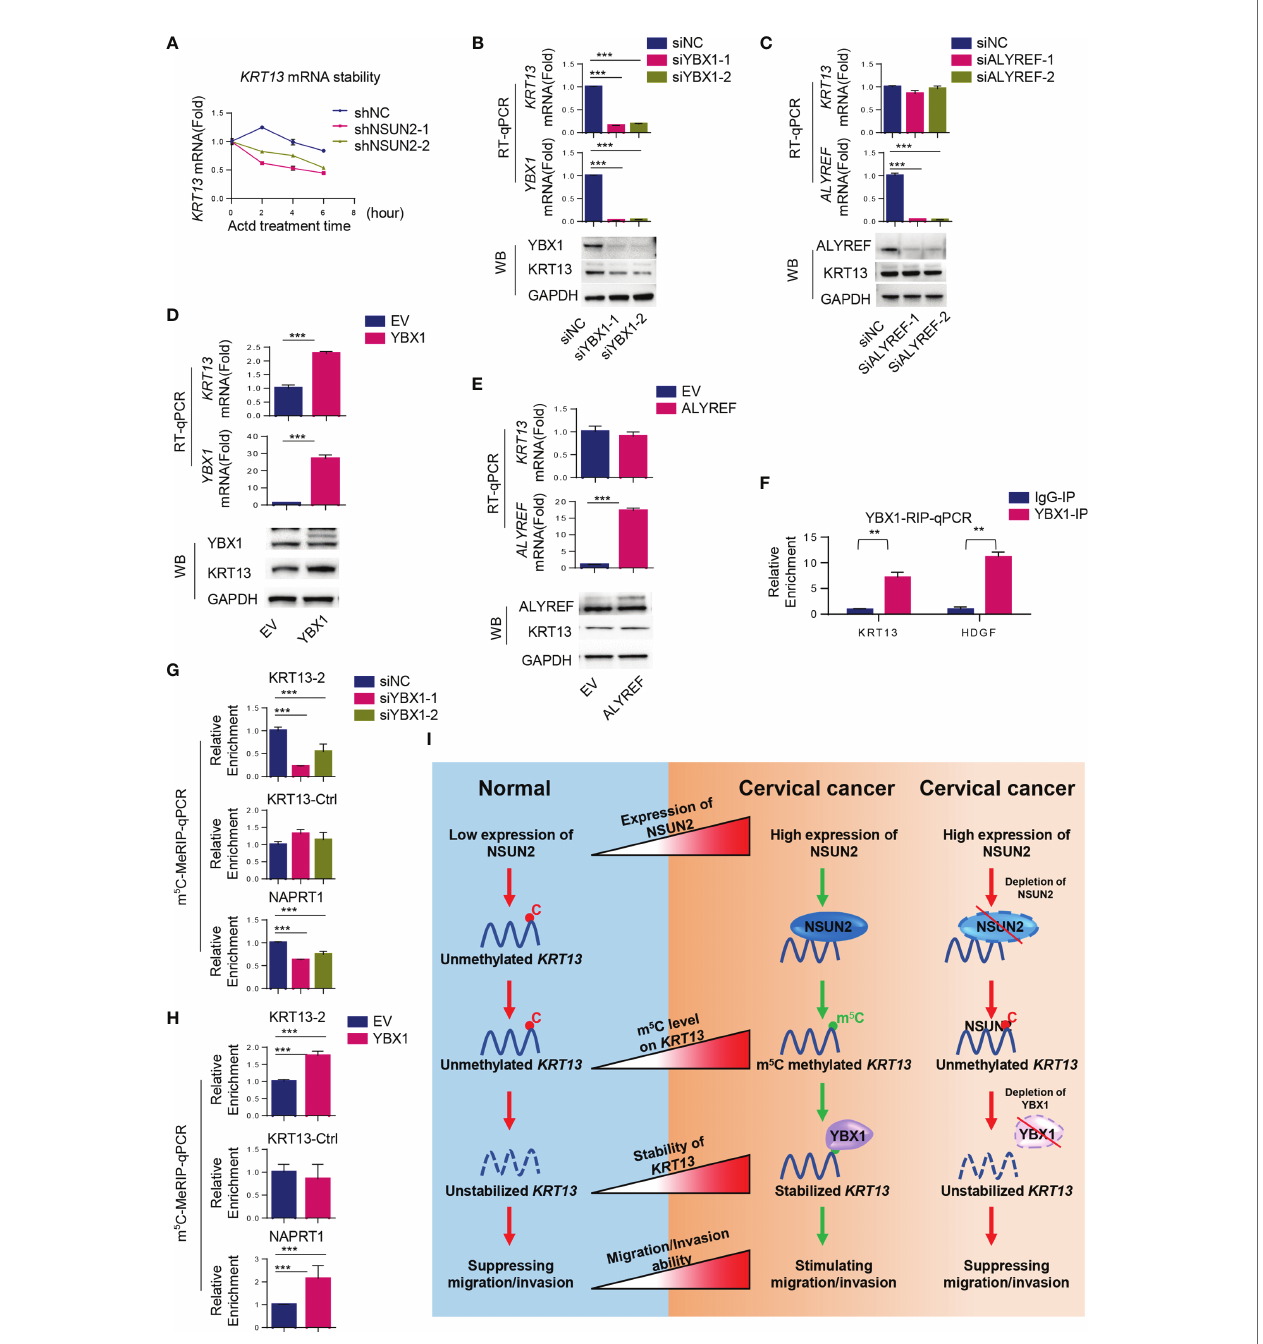
FIGURE 6 | NSUN2 stabilizes KRT13 mRNA by recruiting YBX1. (A) Effect of NSUN2 on the stability of KRT13 mRNA. CaSki cells transfected with two NSUN2- targeting shRNAs were treated with 10 m g/ml RNA synthesis inhibitor Actinomycin D (Actd) for indicated time. Level of KRT13 mRNA was analyzed by RT-qPCR. (B, C) Effect of YBX1 (B) and ALYREF (C) knockdown on KRT13 mRNA and protein level in CaSki cells as assessed by RT-qPCR and Western blot. (D, E) Effect of YBX1 (D) and ALYREF (E) overexpression on KRT13 mRNA and protein level in CaSki cells as assessed by RT-qPCR and Western blot. (F) RIP-qPCR analysis of YBX1- KRT13 interaction. IgG was used as a negative control. (G, H) Effect of YBX1 on m 5 C modi fi cation occurred on KRT13 mRNA. YBX1 was silenced (G) or overexpressed (H) in CaSki cells, and the m 5 C modi fi cation on KRT13 mRNA was measured by m 5 C-MeRIP-qPCR. NAPRT1 was used as a positive